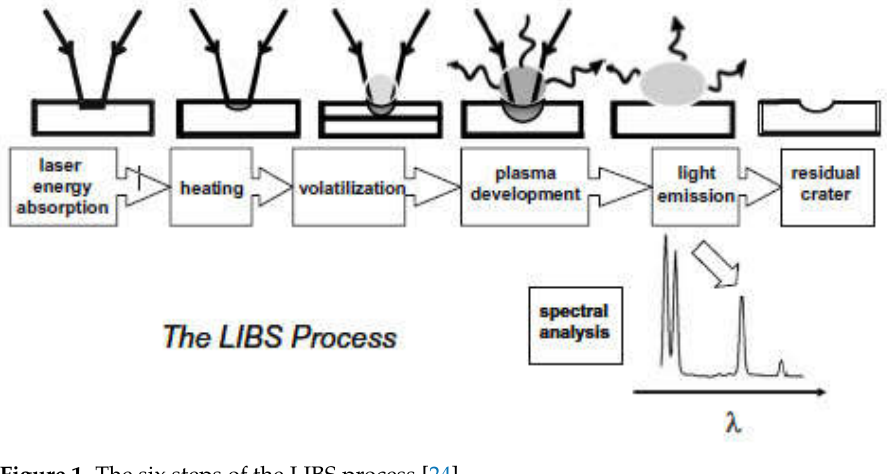
Figure 1. The six steps of the LIBS process [24].